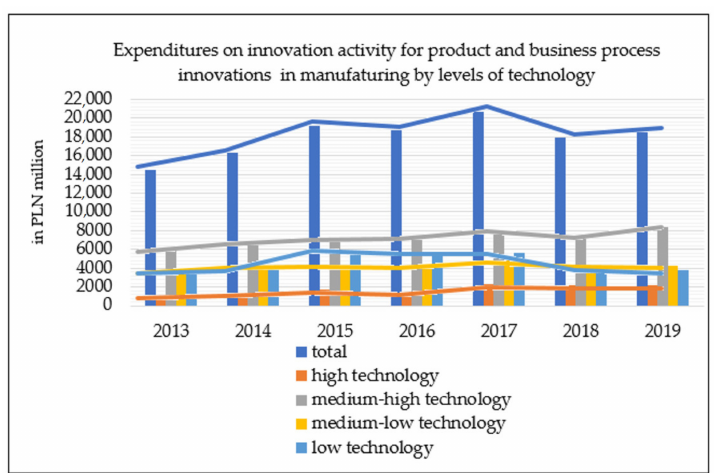
Figure 12. The amount of spending on innovation activity for product and business process inno- vations according to the levels of technology in manufacturing in Poland. Source: adapted with permission from Refs. [101–109].